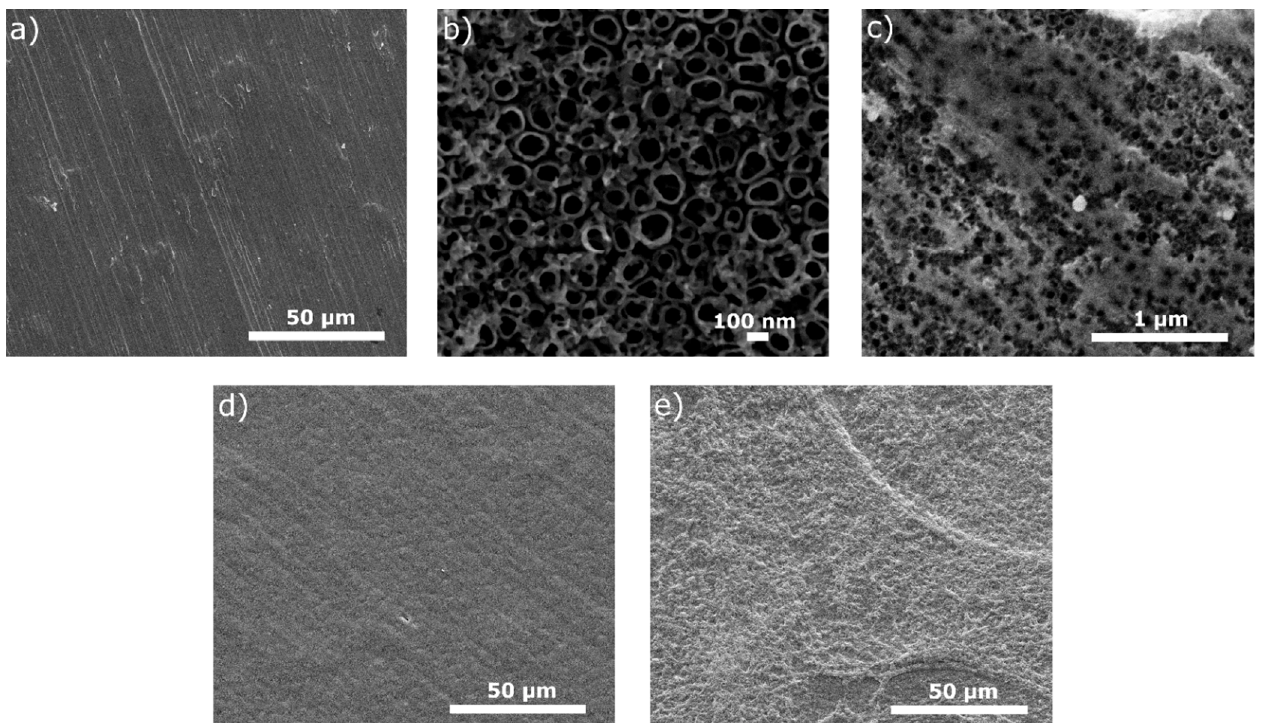
Figure 1. Microstructures of surfaces after different modifications: ( a ) ground, ( b ) ground and anodically oxidized to obtain titanium nanotubes, ( c ) ground, oxidized, and coated with Ag layer, ( d ) ground, oxidized, Ag-decorated and coated with chitosan/Eudragit 100, ( e ) ground, oxidized, Ag-decorated and coated with chitosan/P4VP.